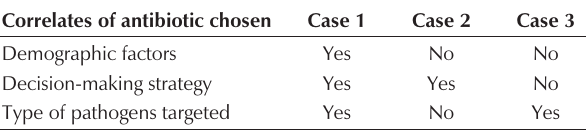
Correlates of antibiotic choice: Summary of results